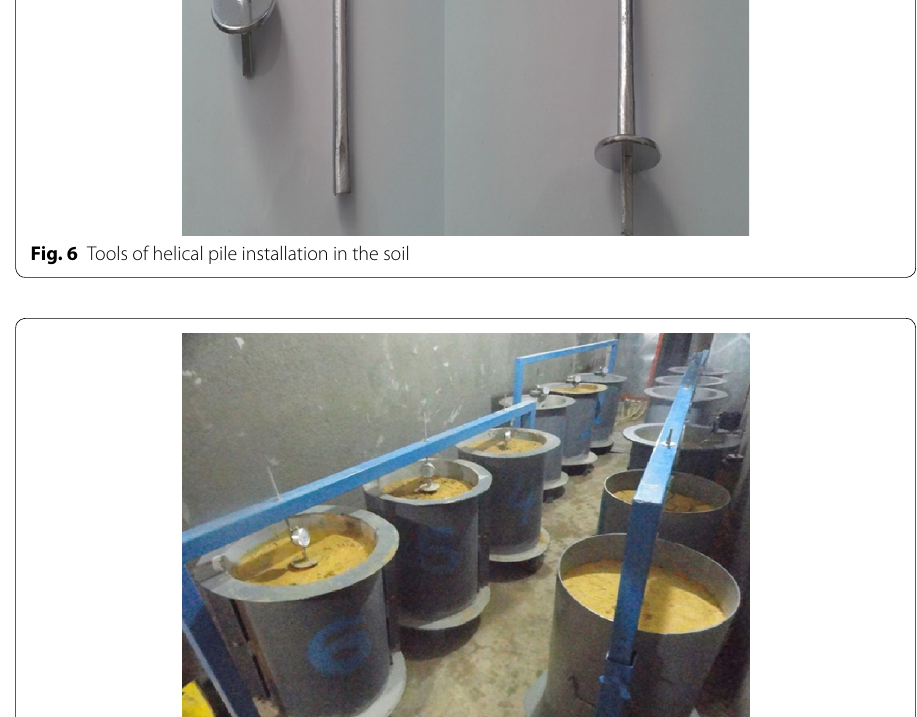
Fig. 7 Manufactured frames of uplift movement measurement of helical